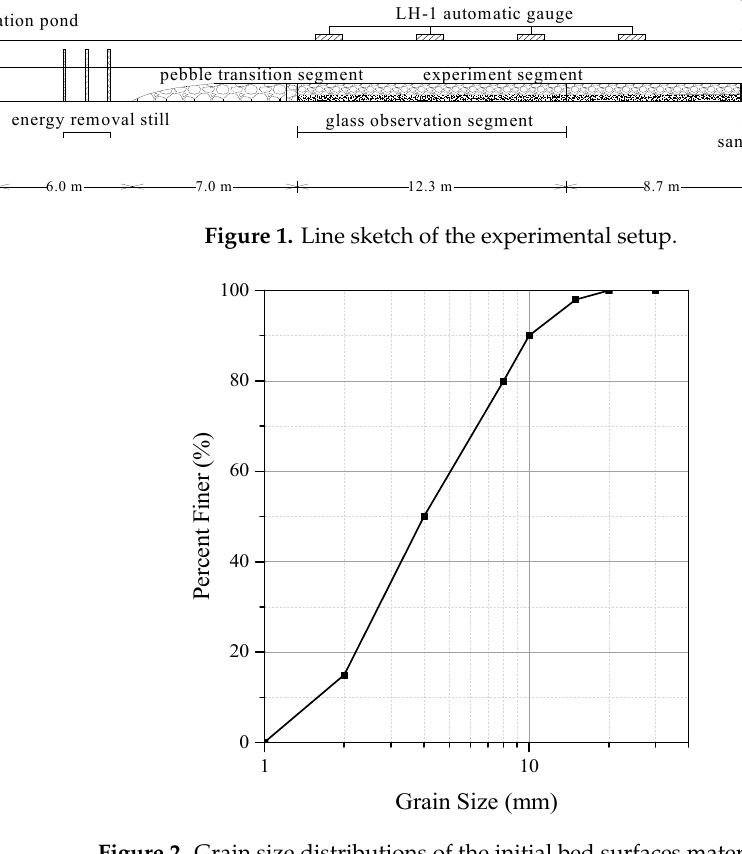
Table 1. Hydraulic condition for each set of laboratory flume experiments.